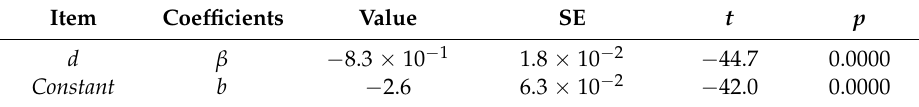
Table 5. Coefficients and t -test results of the traditional depth bias model.